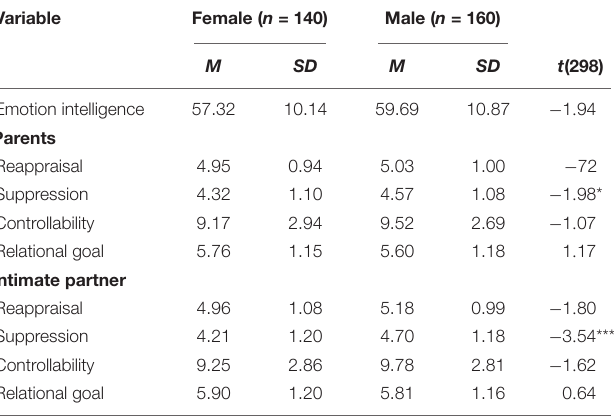
TABLE 1 | Means and standard deviations of the research variables for male and female